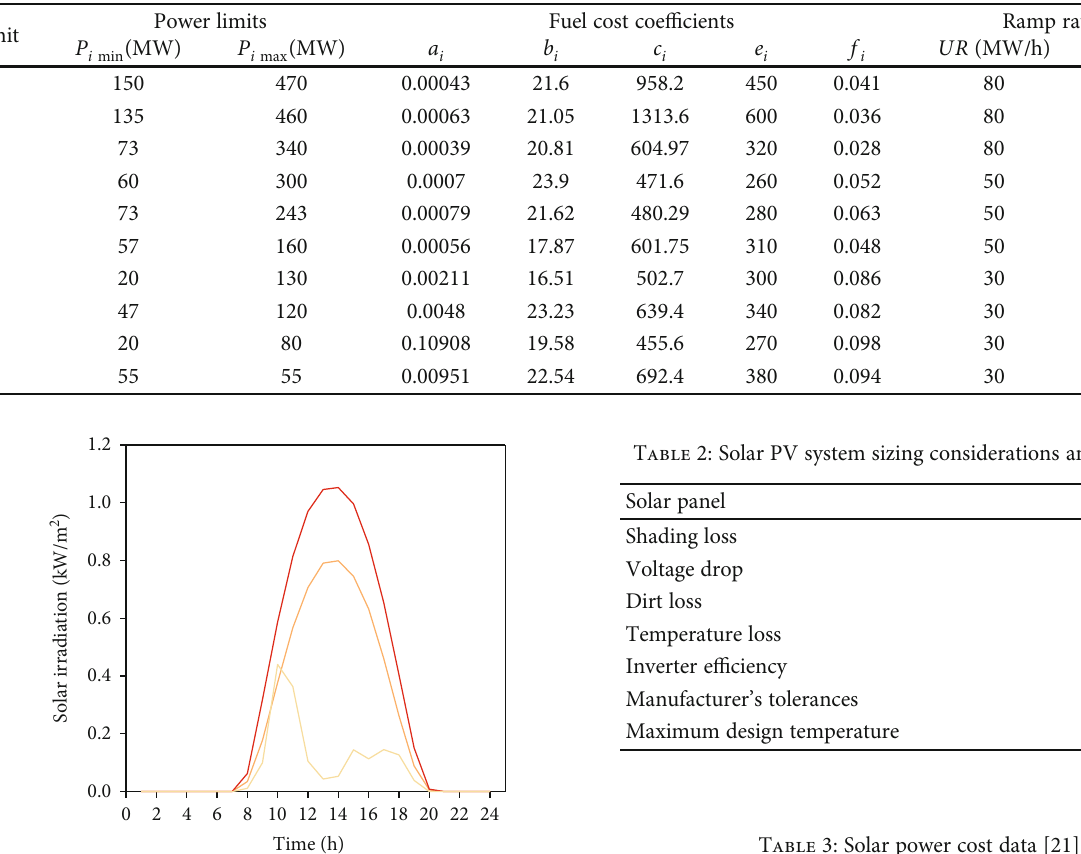
Table 1: Characteristics of the ten thermal generation units [19].